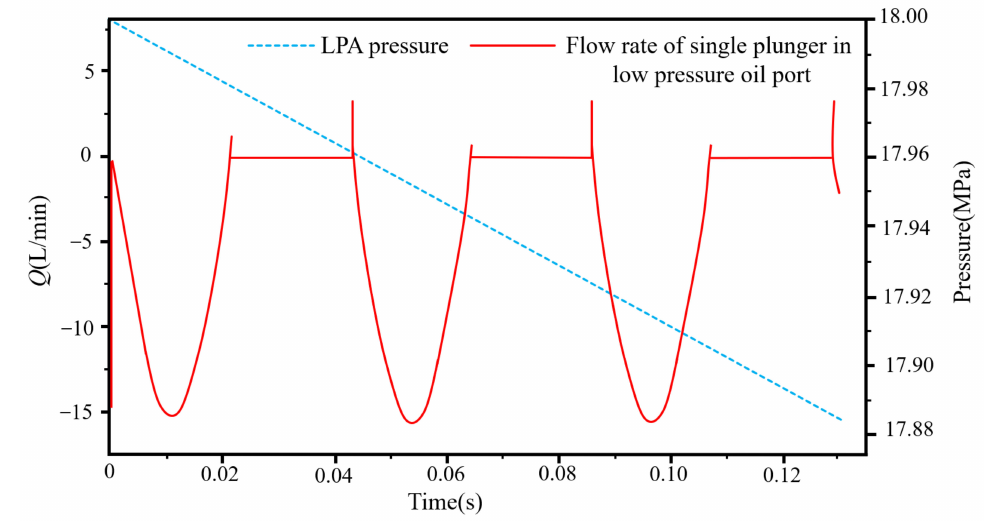
Figure 4. Diagram of low pressure accumulator (LPA) pressure and single plunger flow rate at low pressure oil port on pump analysis.